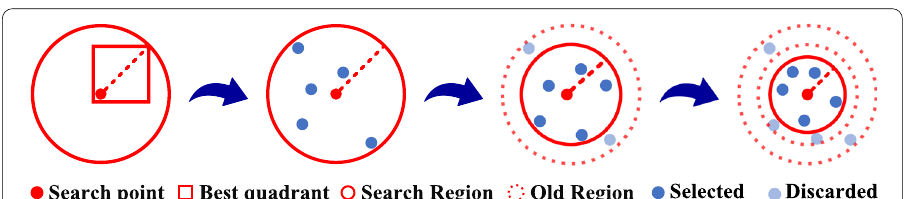
Fig. 11 Illustration of the k NN lookup process (Assuming k = 5